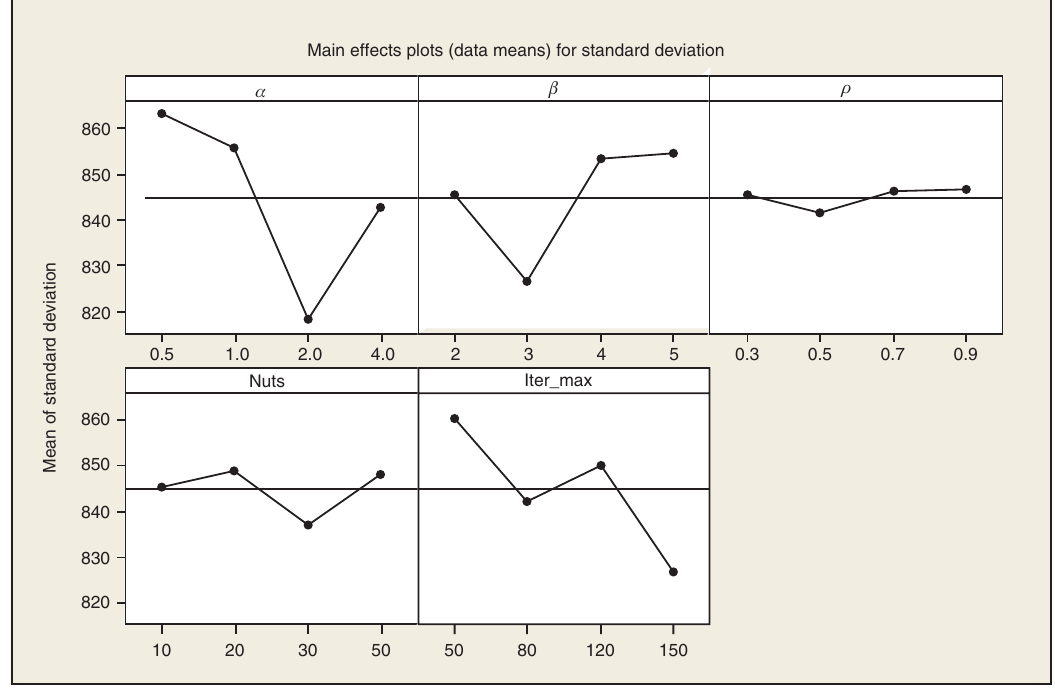
Figure 6: Main Effects Plots for Standard Deviation.